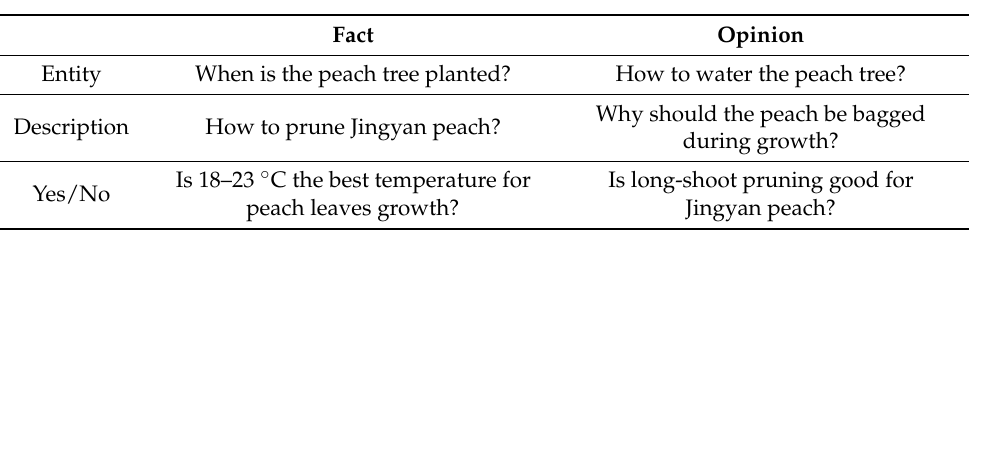
Table 4. Six types of example